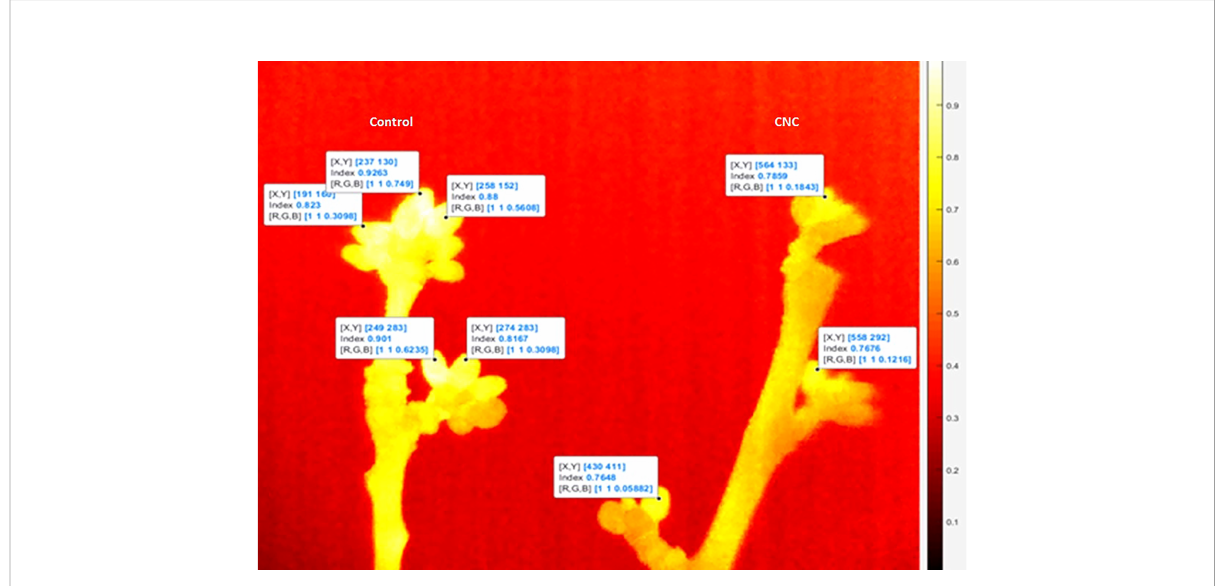
FIGURE 2 Thermography emissivity image of untreated (right) and 2% (wt) cellulose nanocrystal dispersion-treated (left) sweet cherry fruiting spurs and fl ower